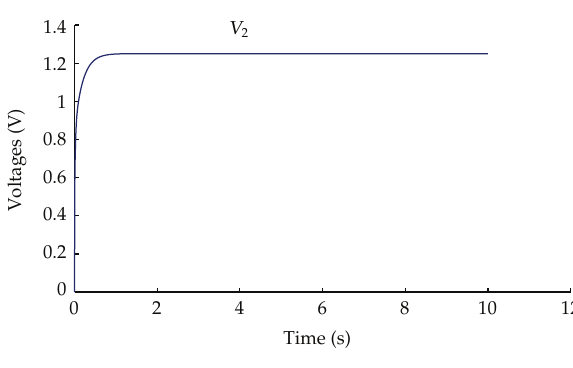
Figure 9: The input voltage of the joint